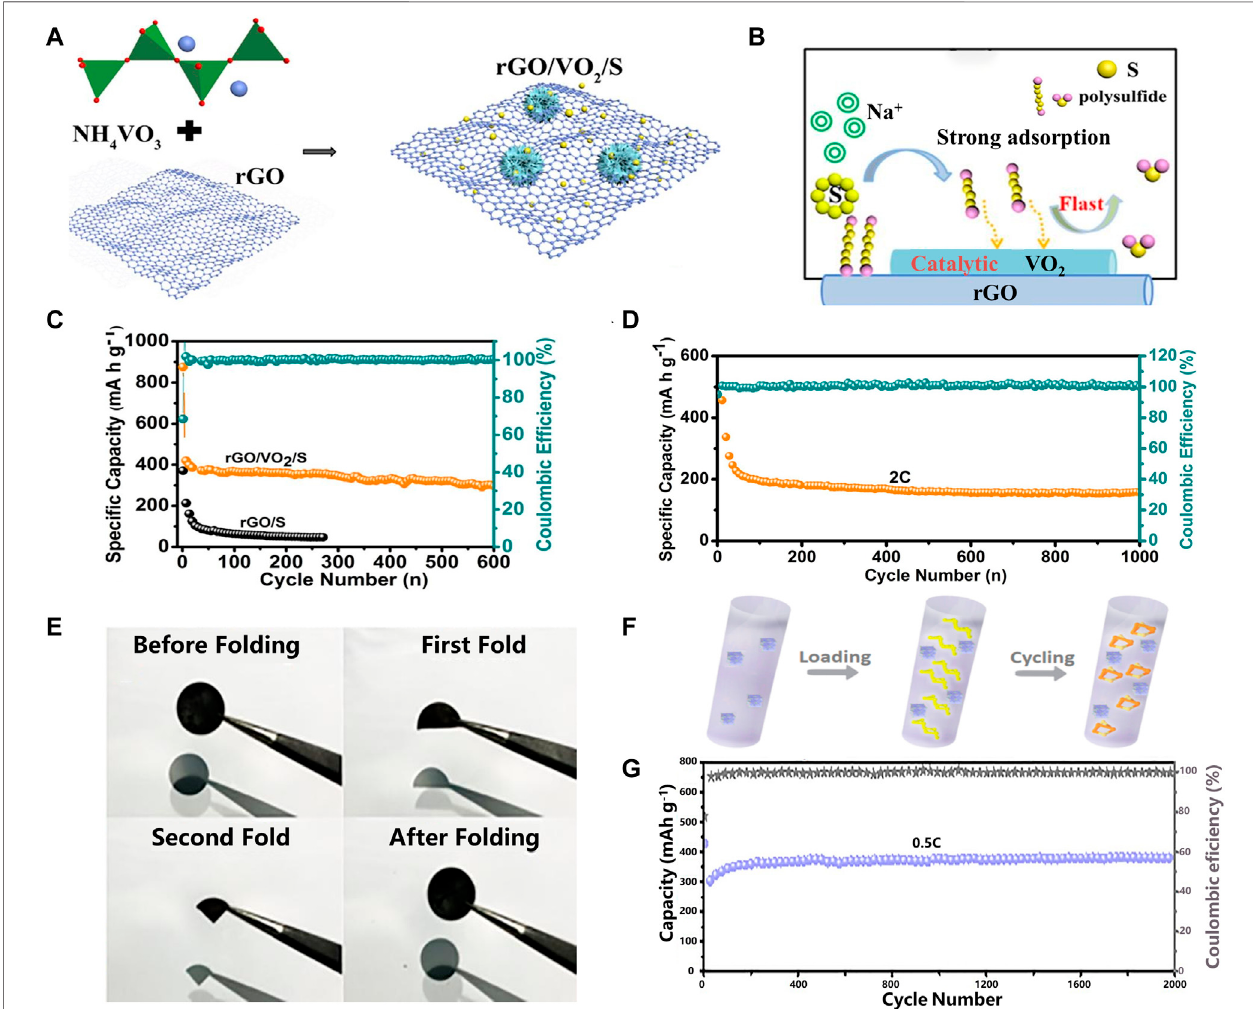
FIGURE 3 | Schematic of the (A) preparation and (B) advantages of the rGO/VO Cycling stability at 2C for 1,000 cycles; (E) Digital photos of the VC-CNFs as a freestanding electrode; (F) VC-CNFs@S cathode; (G) Prolonged cycling performance at 0.5C (activated at 0.1C) (Du, et al., 2020; Tang, et al., 2020).